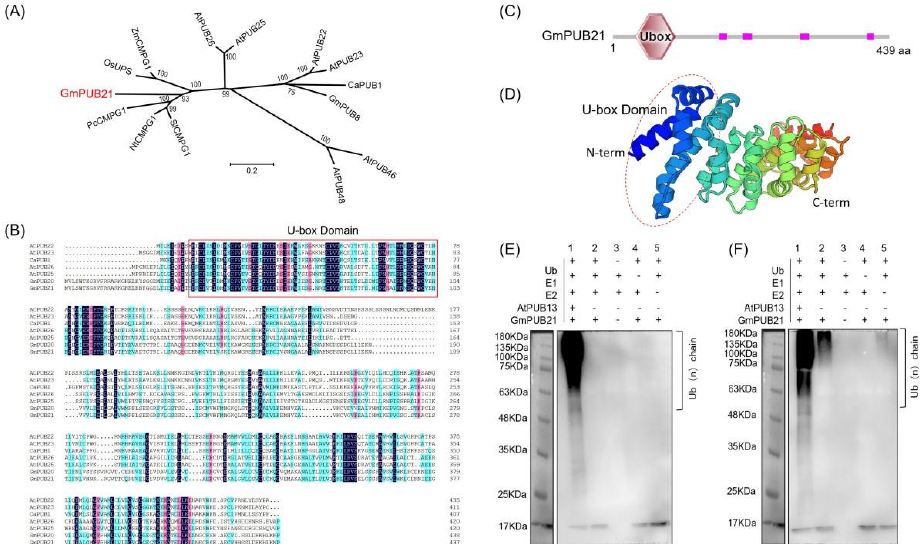
Figure 1. Cloning and characterization of the soybean GmPUB21 gene encoding a E3 ubiqui- tin ligase. ( A ) Phylogenetic analysis of U − box type ubiquitin ligase (PUB) genes from soybean, Arabidopsis, parsley, rice, tobacco, tomato, and hot pepper. The dendrogram was conducted in MEGA4.0 software with the neighbor − joining method. ( B ) Multiple sequence alignment of amino acid sequences of GmPUB21 and other U − box type ubiquitin ligase (PUB) genes with DNAMAN. ( C ) Schematic structures of GmPUB21, open bars indicate coding regions, hexagon represent the U − box motif, and pink bars depict the low complexity. ( D ) The structure of GmPUB21 peptides was constructed by homology modeling using SWISS − MODEL. ( E ) The purified His − GmPUB21 was used for self − ubiquitination assays. ( F ) The pre − incubated His − GmPUB21 was used for self-ubiquitination